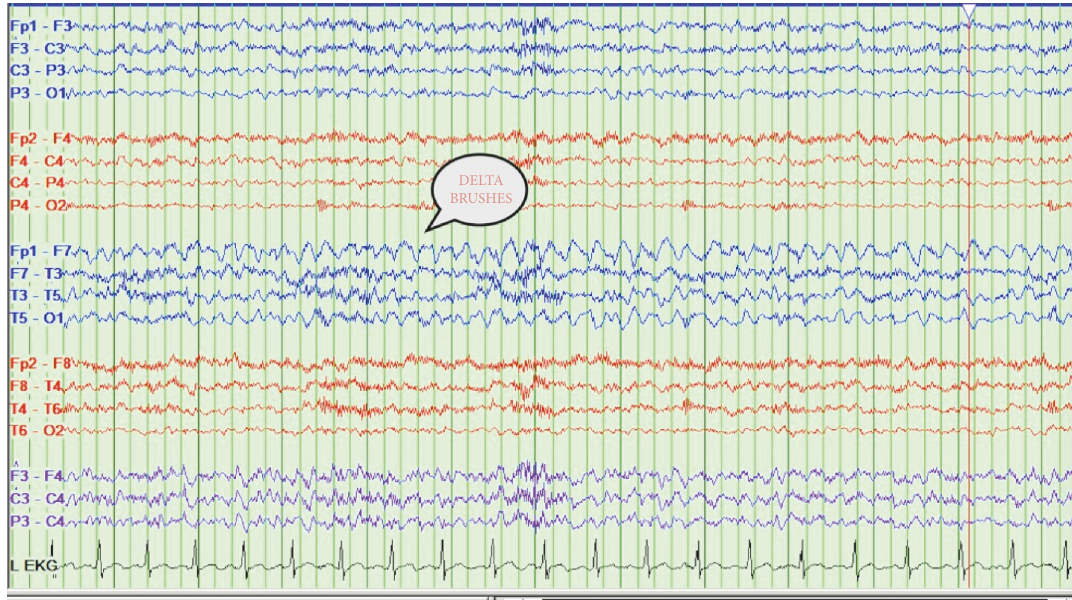
Figure 3: Electroclinical seizure: rhythmic delta activity originating from left frontotemporal